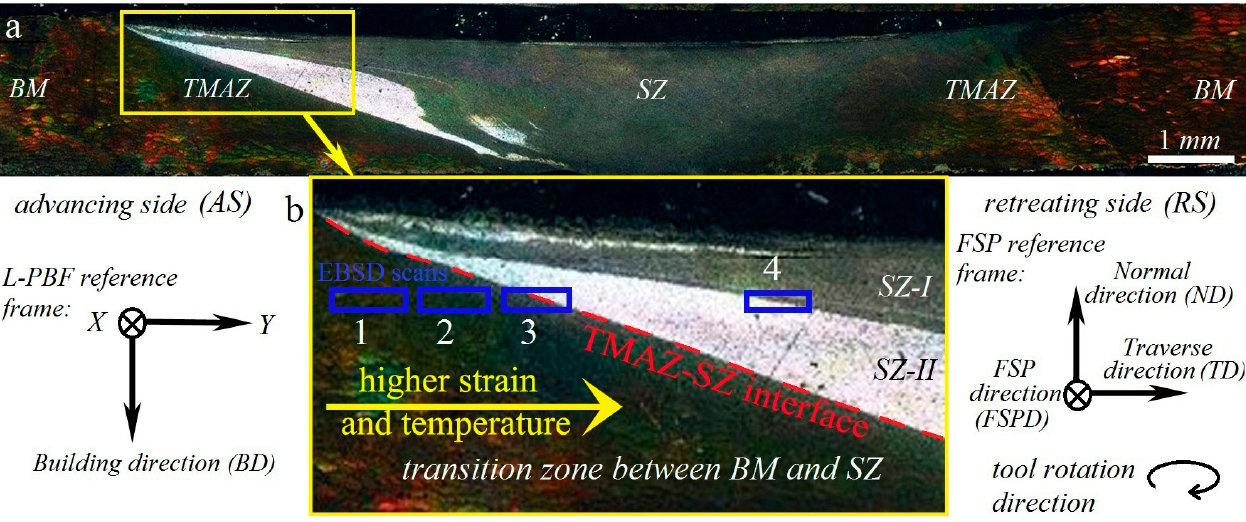
Figure 2. ( a ) Cross-sectional macrostructure of the 1-pass friction stir processed sample. ( b ) The higher magnification of the transition zone between BM and SZ on the advancing side and corresponding details of the L-PBF reference frame, FSP reference frame, and tool rotation direction. The blue rectangles indicate the different areas of EBSD scans.